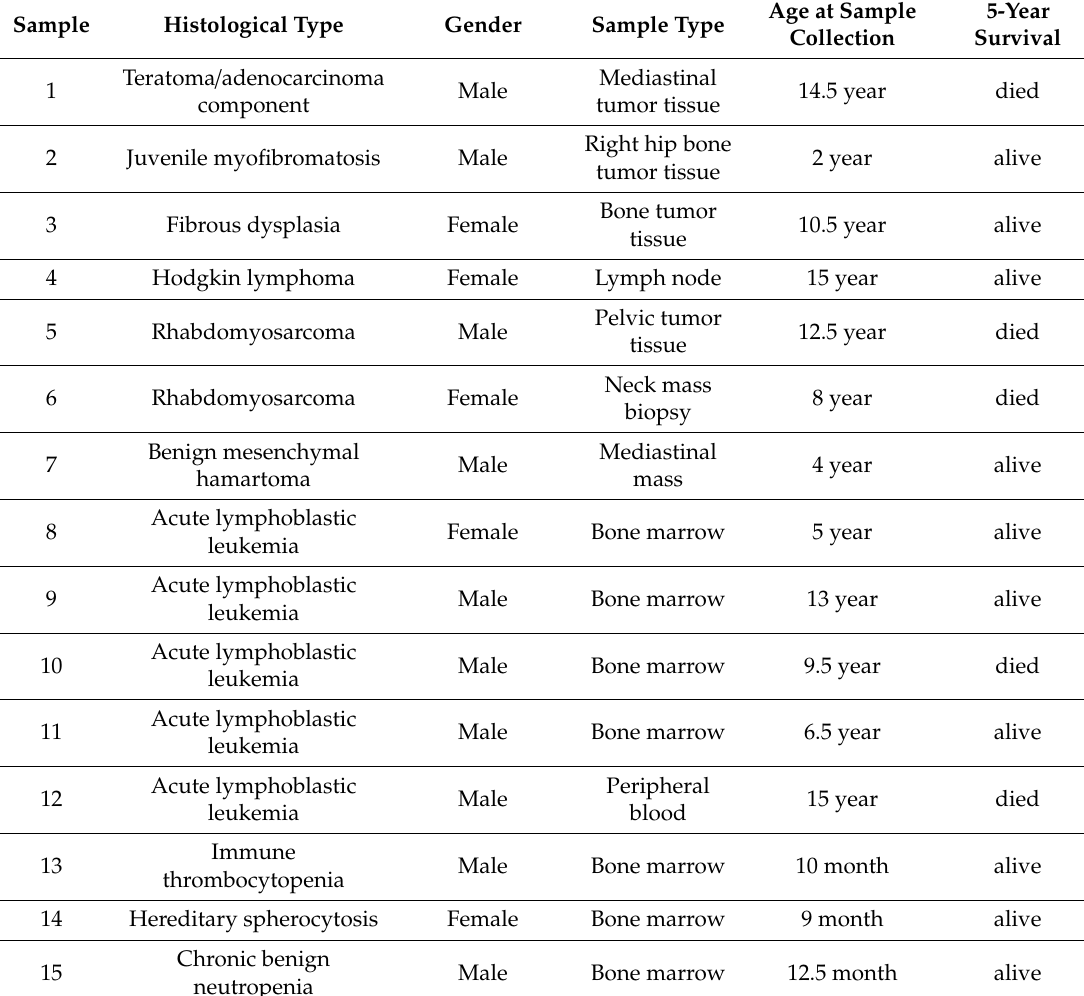
Table 3. Clinicopathology data of 15 pediatric hematological and oncological